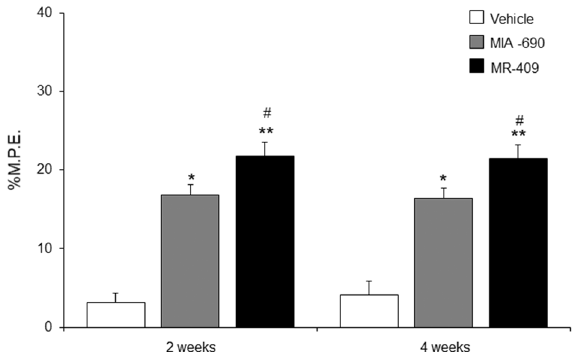
Figure 4. Effect of MIA-690 (5 µg) and MR-409 (5 µg) (n = 6 for each group of treatment) s.c. administration on the analgesic response at the temperature of 54.0 ± 0.4 °C in hot plate test. The antinociceptive activity is expressed as percentage of the maximum possible effect (% M.P.E.). Data are expressed as means ± S.E.M. and analyzed by analysis of variance (ANOVA) followed by Bonferroni post-hoc test * p < 0.05, ** p < 0.01 versus vehicle; # p < 0.05 versus MIA-690.